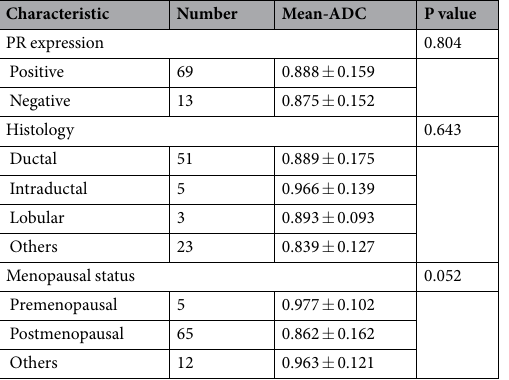
Table 2. Comparison of ADC values in tumours according to histopathological